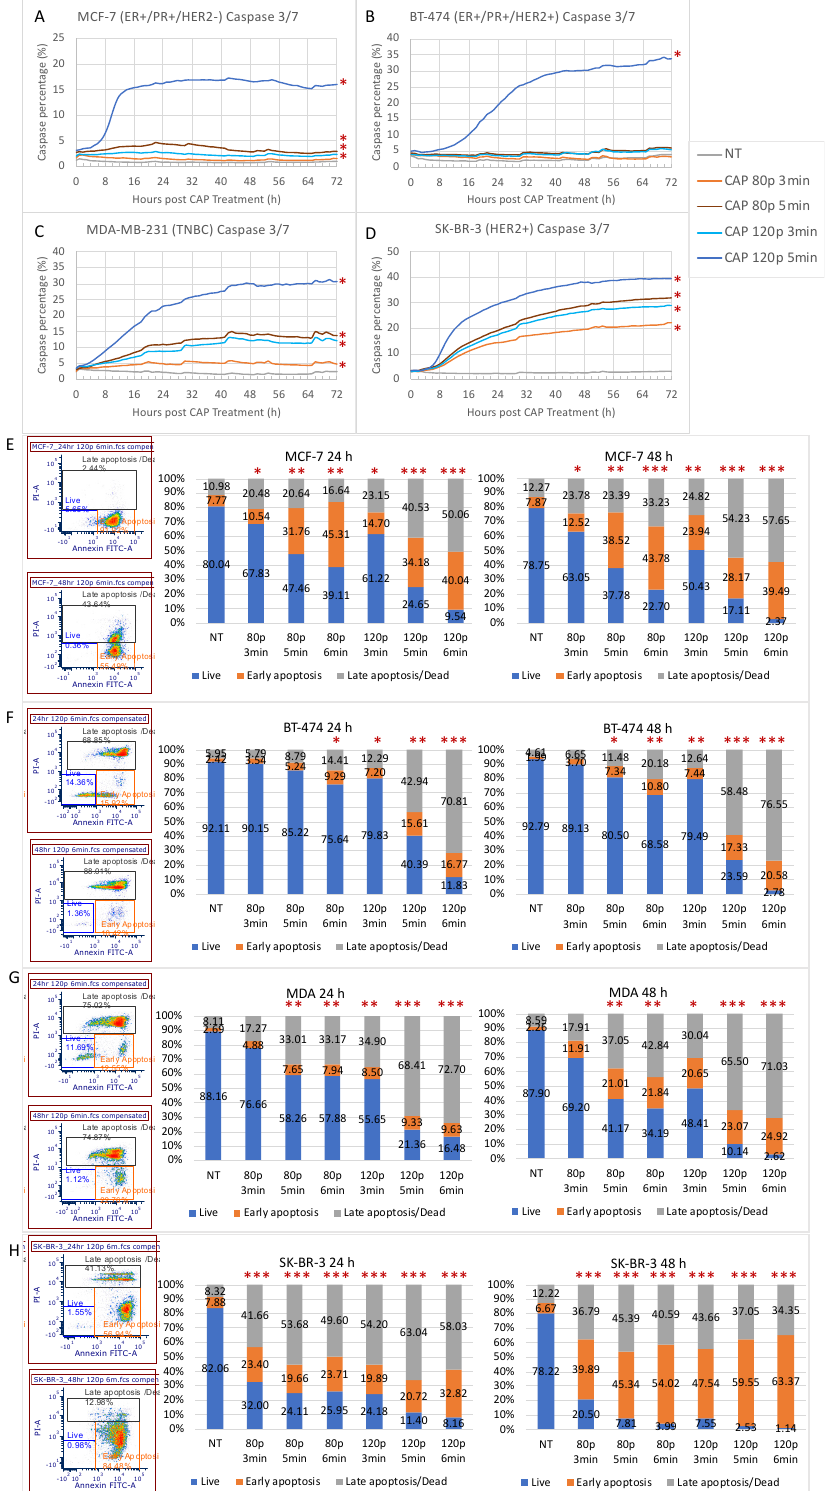
Figure 3. Caspase 3/7 activity of breast cancer cell lines at 0–72 h post-CAP treatment ( A – D ) Quantification of caspase 3/7 activity of MCF-7, BT-474, MDA-MB-231, and SK-BR-3 over 72 h post-CHCP treatment by IncuCyte Live-Cell Imaging. ( E – H ) Representative images and averaged quantification plots of ‘live’, ‘early apoptosis’, and ‘late apoptosis/dead’ populations of MCF-7, BT-474, MDA-MB-231, and SK-BR-3 at 24 and 48 h post-CHCP treatment by flow cytometry. (* above the bars denotes statistical significance of CAP-treated group compared to corresponding No Treatment group. * p < 0.05, ** p < 0.01, and *** p <